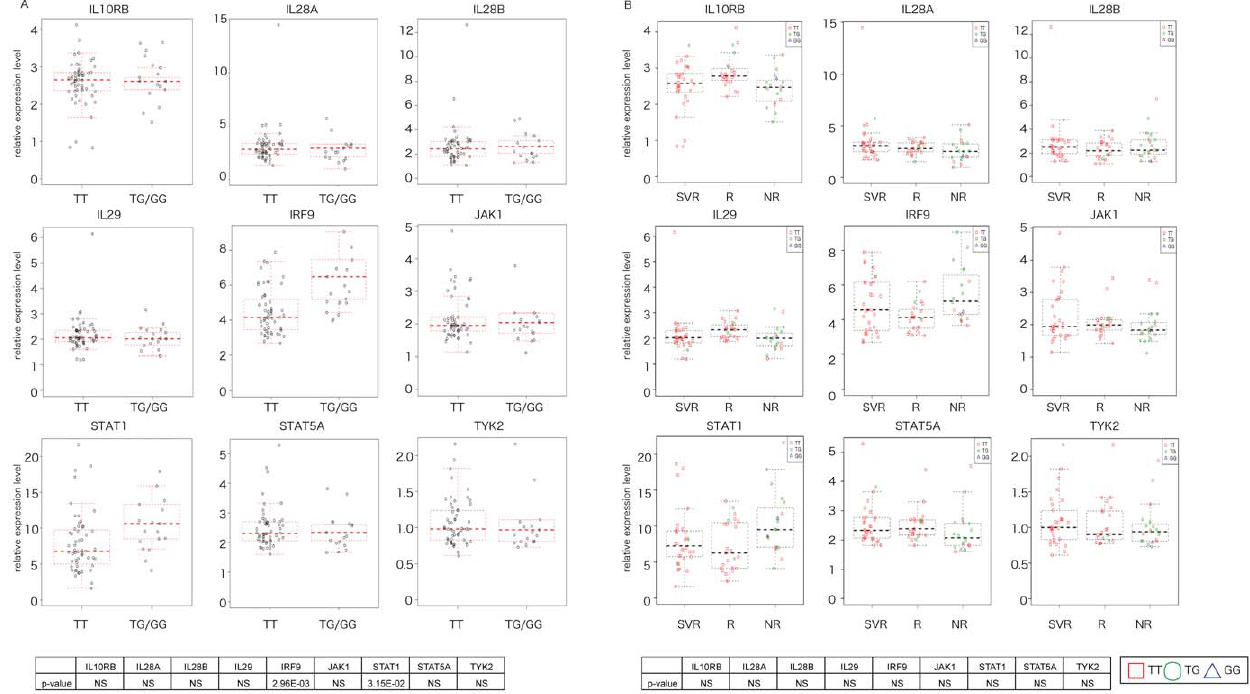
Figure 3. The relationship among the expression of IFN lambda-related genes, IL28B polymorphism and clinical outcome. (A) The relationship between the expression level of IFN lambda related genes (TYK2, STAT5A, STAT1, IL10RB, IL29, IL28A, IL28B, JAK1, and IRF9) in the liver of CH patients and IL28B with genotype. The p-value of the relationship between gene expression level and IL28B genotype is also presented. (B) The relationship among IFN lambda related genes, clinical outcome, and IL28 genotype in individual cases. Summary table of the p-value is also shown. NS was not significantly different.